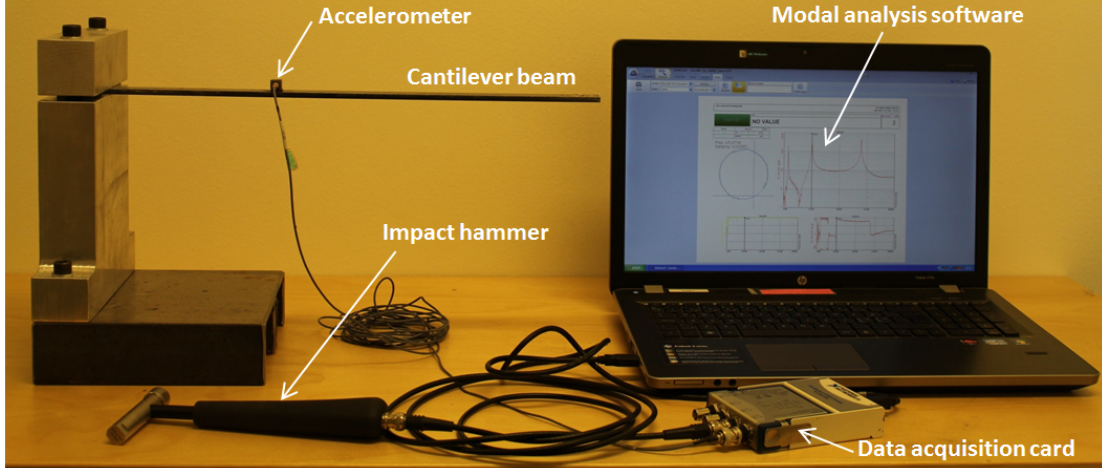
Figure 1. Experimental modal analysis